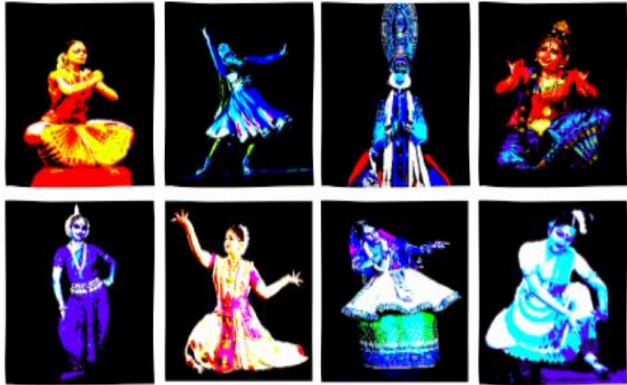
Figure 5. Sample images from dataset after